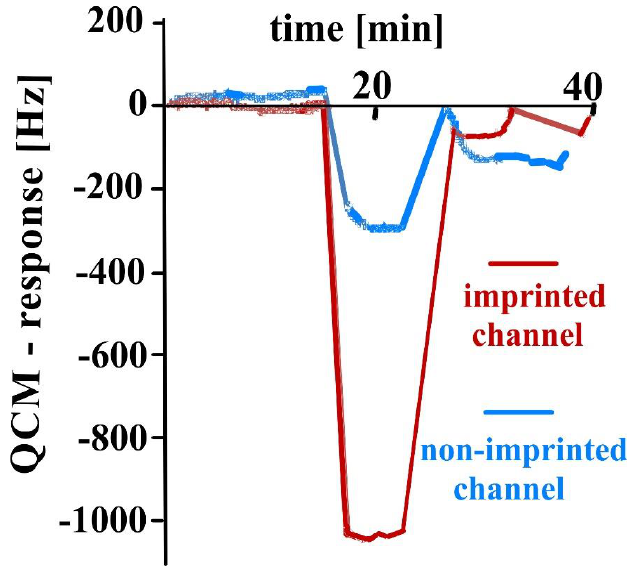
Figure 4. Mass-sensitive sensor responses to bacteria subtilis spores to imprinted and non-imprinted dual electrodes as a function of time. Chemosensors 2020 , 8 , x FOR PEER REVIEW